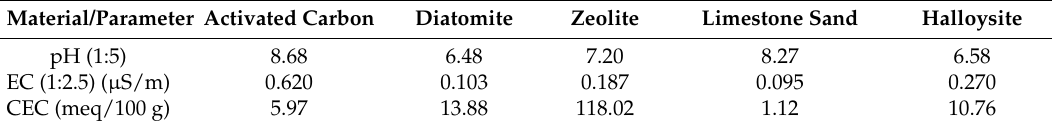
Figure 2. SEM images along with EDS analysis. Table 2. Physico-chemical properties of the reactive materials.